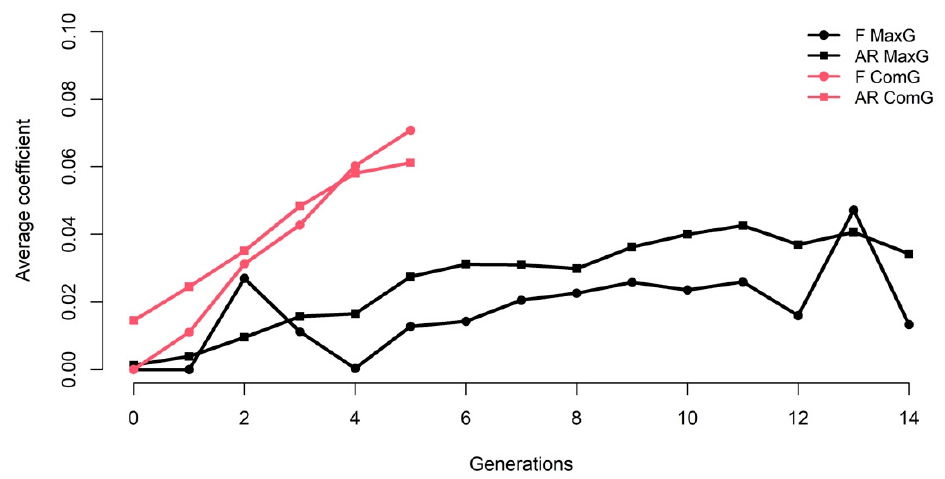
Figure 1. Evolution of the average pedigree-based inbreeding (F) and relatedness (AR) coefficients through complete (ComG) and maximum (MaxG) generations